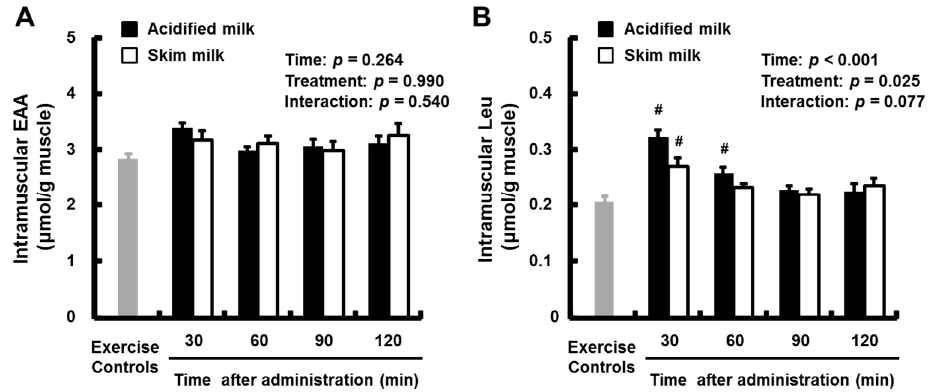
Figure 6. Intramuscular free EAA ( A ) and Leu ( B ) levels in rats administered acidified milk or skim milk. Data are presented as means ± SEM ( n = 6–8). # Significantly different from exercise-only controls, p < 0.05. EAA, essential amino acids; Leu, leucine; SEM, standard error of the mean.